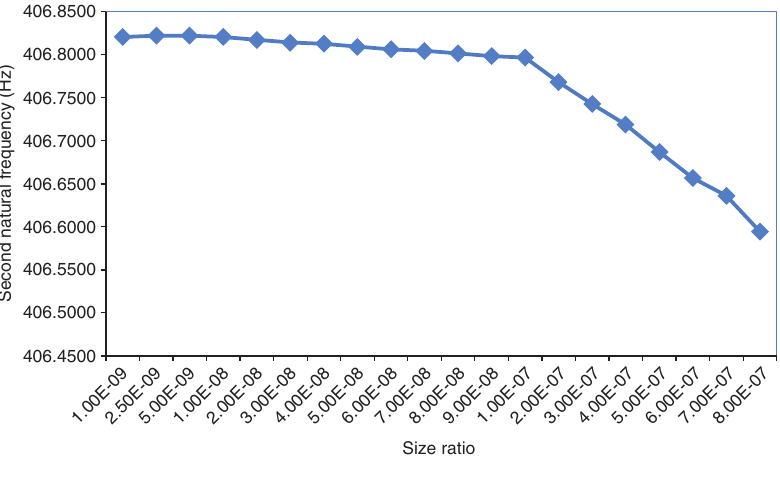
Figure 14: Variations of the second natural frequency of the cantilever beam with size